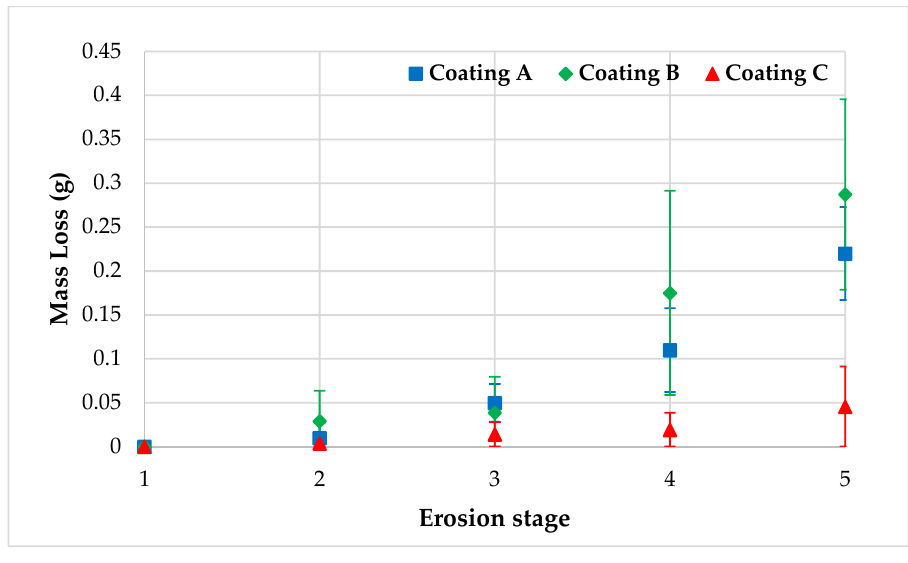
Figure 14. Sample mass loss at each erosion stage.